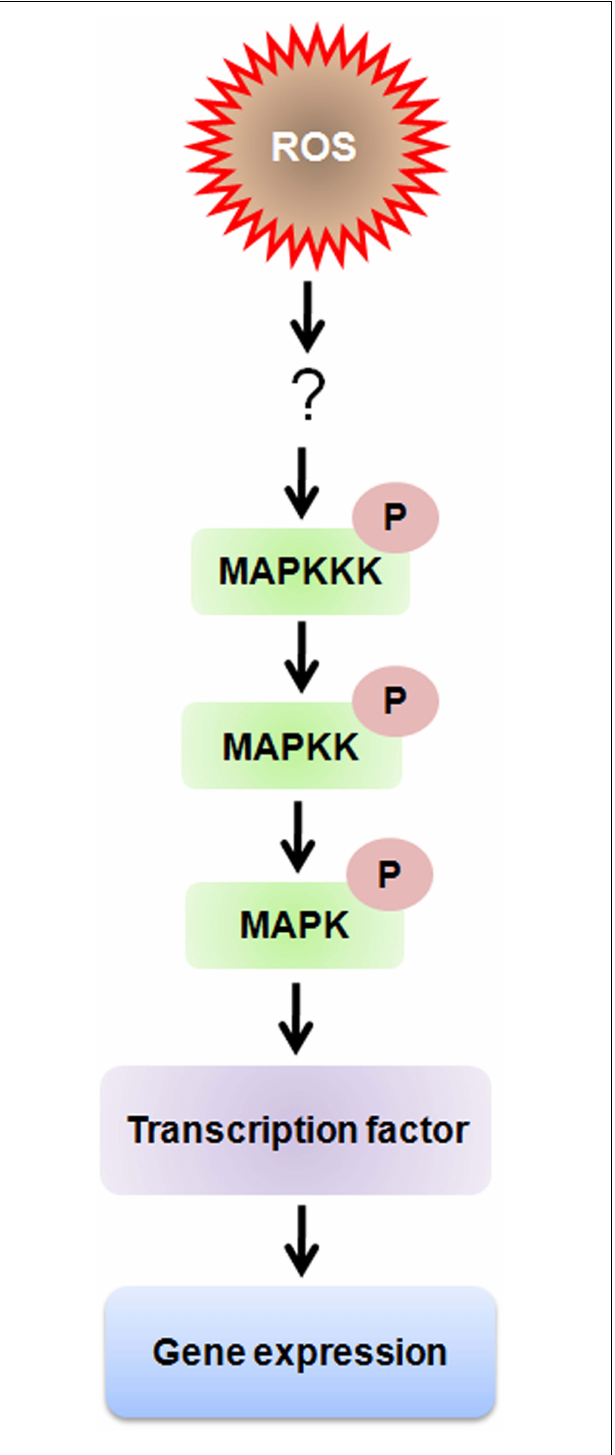
FIGURE 2 | Schematic depiction of cellular ROS sensing and signaling mechanisms through MAP kinase signaling pathway. Intracellular ROS can also influence the ROS-induced mitogen-activated protein kinase (MAPK) signaling pathway through inhibition of MAPK phosphatases (PPases) or downstream transcription factors. Whereas, MAP kinases regulate gene expression by altering transcription factor activity through phosphorylation of serine and threonine residues, ROS regulation occurs by oxidation of cysteine residues.